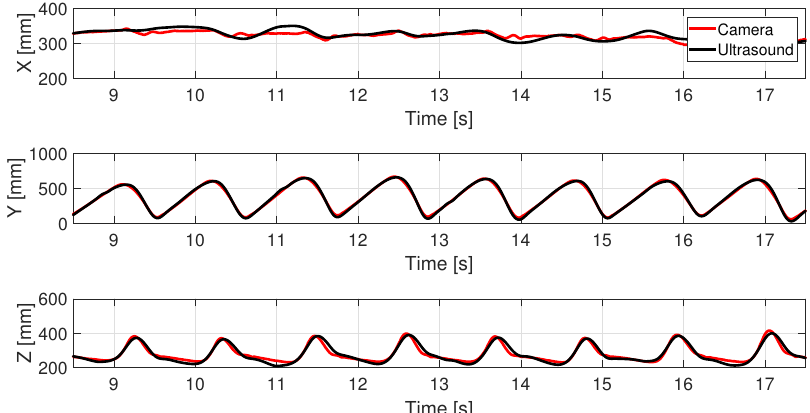
Figure 9. The comparison of the 3D coordinates of one marker attached to one of the lower limbs extracted from the proposed ultrasonic system and motion capture system for a walking speed of 0.83